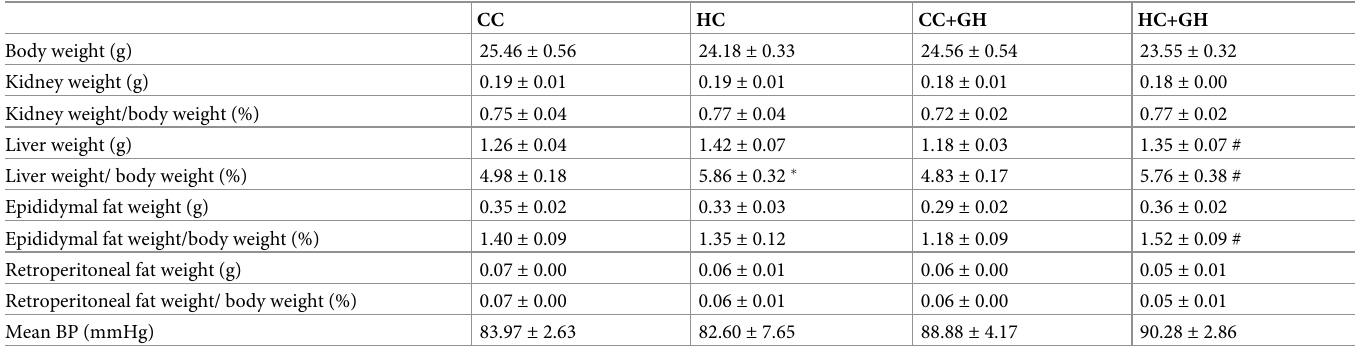
Table 2. Biometric parameters of week 9 offspring.